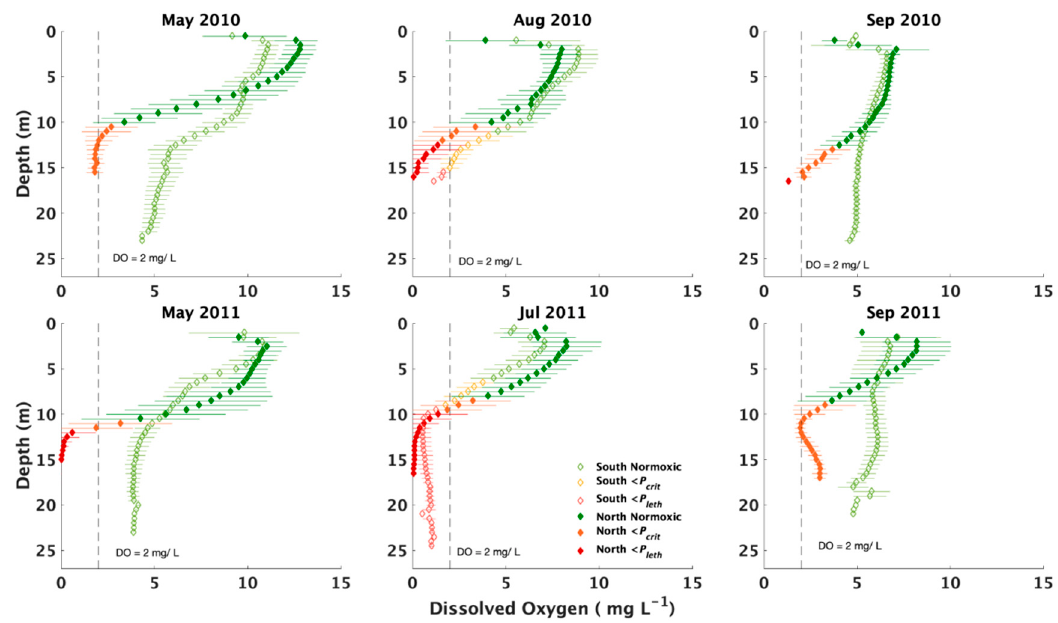
Figure 3. Average dissolved oxygen (diamonds, mg L − 1 ) from the CTD casts taken at North (closed) and South (open) stations during 2010 and 2011 cruises. Symbols represent mean values in 0.5 m bins from all CTD measurements at each depth, and horizontal lines indicated standard deviations. Color fillings represent partial pressure: above P crit (green), between P crit and P leth (orange), and below P leth (red). Dashed black lines indicated dissolved oxygen = 2 mg L − 1 . Modified from [64].